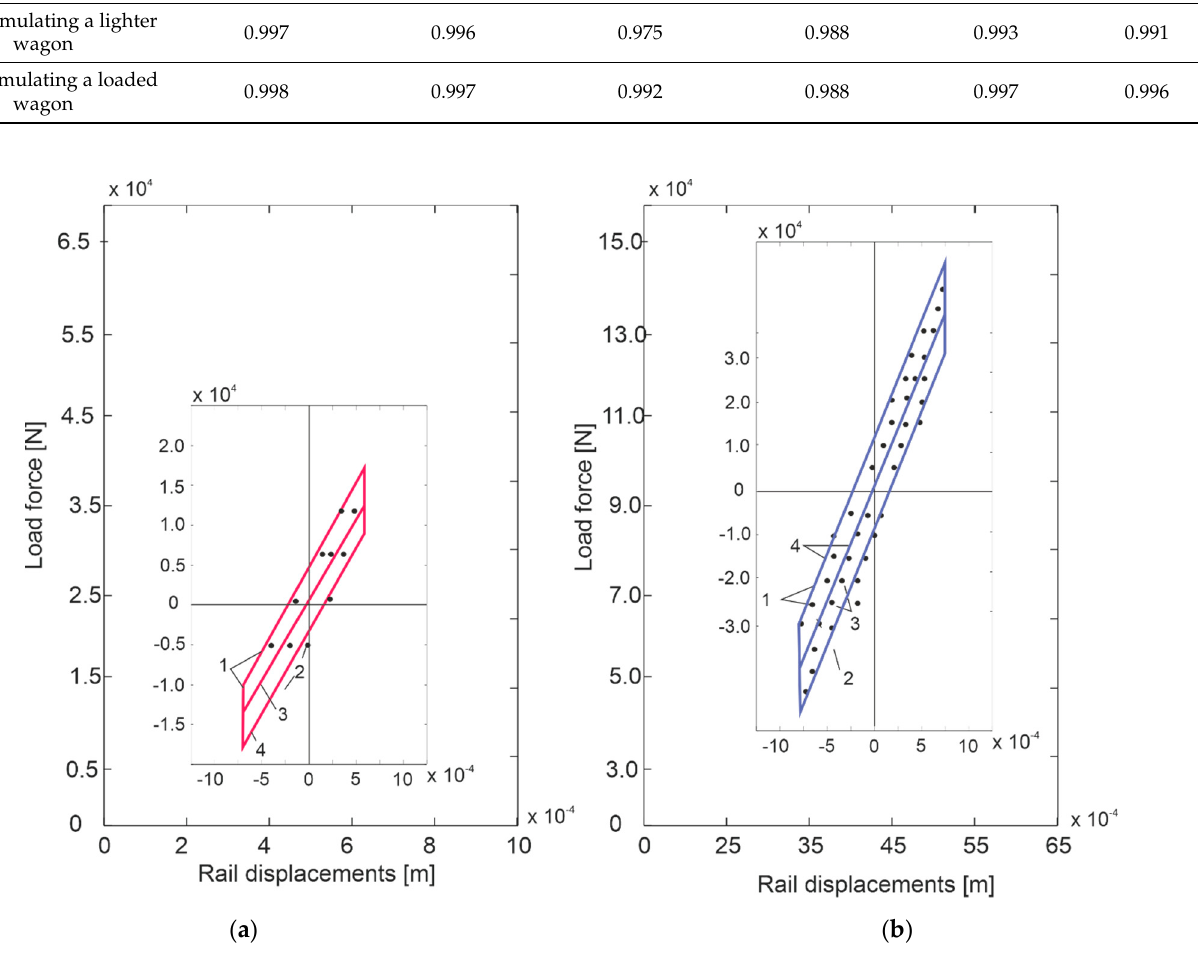
Figure 5. Results of checking the linear relationship between force and displacement under load and headstock relief: ( a ) variant I, ( b ) variant II; 1—load, 2—unload, 3—average of load and unload, 4—simple approximation.